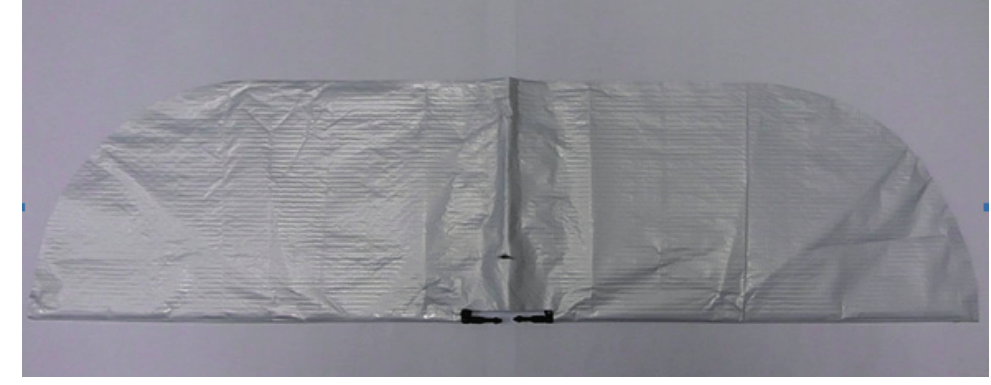
Figure 22. Orcon cambered thick wing.